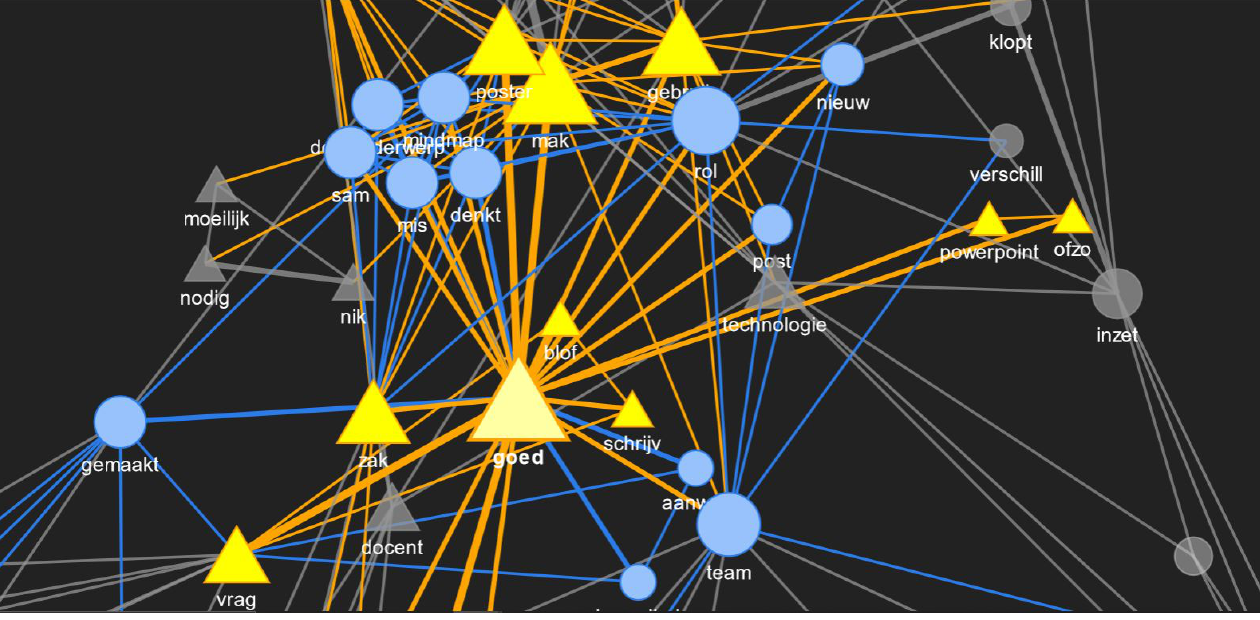
Figure 13. A part of the network graph with the highest betweenness centrality node (“goed”) highlighted along with its neighbouring